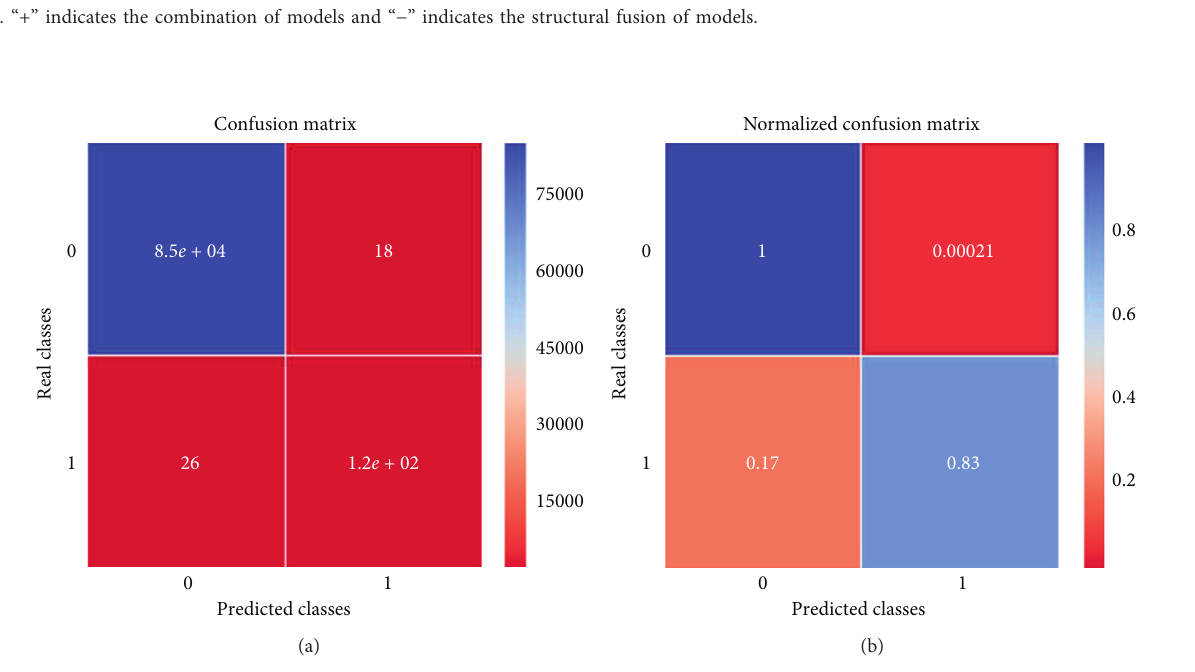
Figure 13, SMOTETomek + LSTM in Figure 14, and kNN- SMOTE-LSTM in Figure 15.